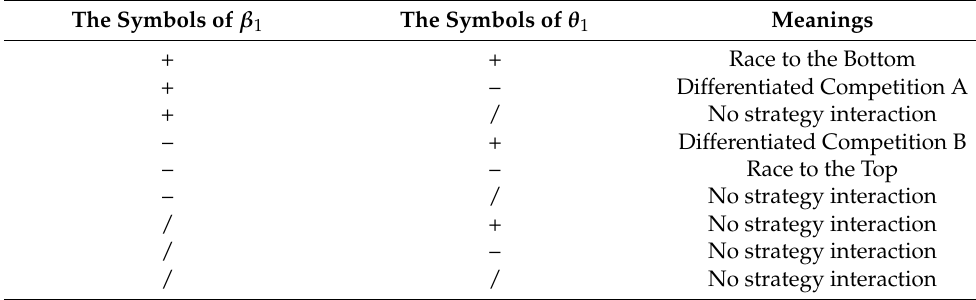
Table 7. Symbols and meanings of environmental regulation coefficients.